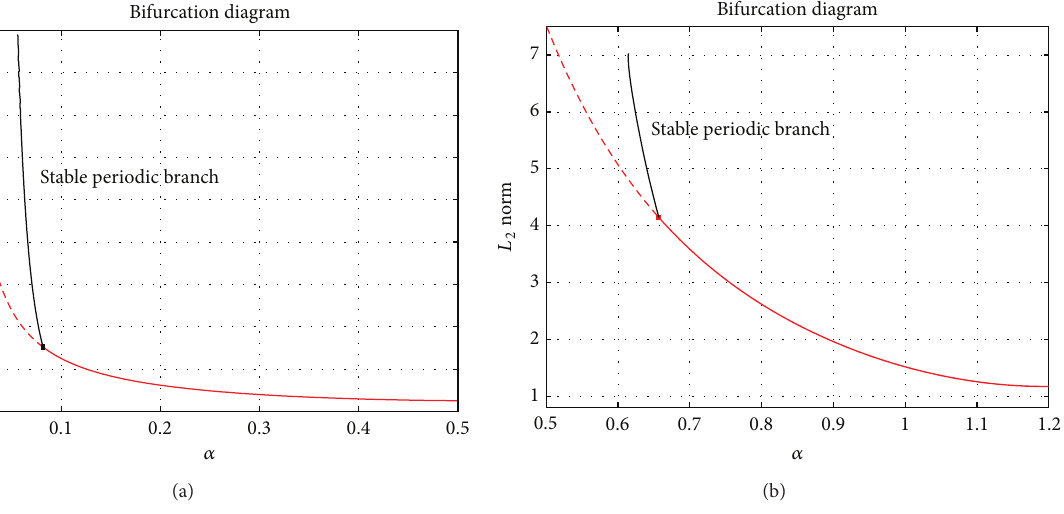
Figure 4: Case 3. (a) 𝑚 = 1 , (b) 𝑚 = 3 .